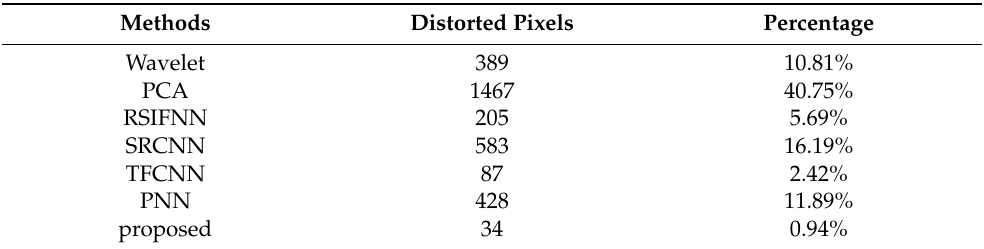
Table 4. The quantitative statistics of distorted pixels of DL-based pansharpening methods (down- sampled GF-2 image).